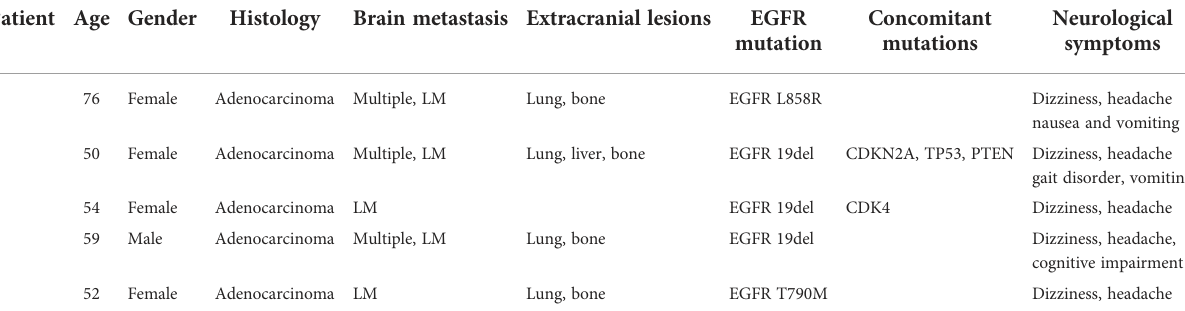
TABLE 1 Patient